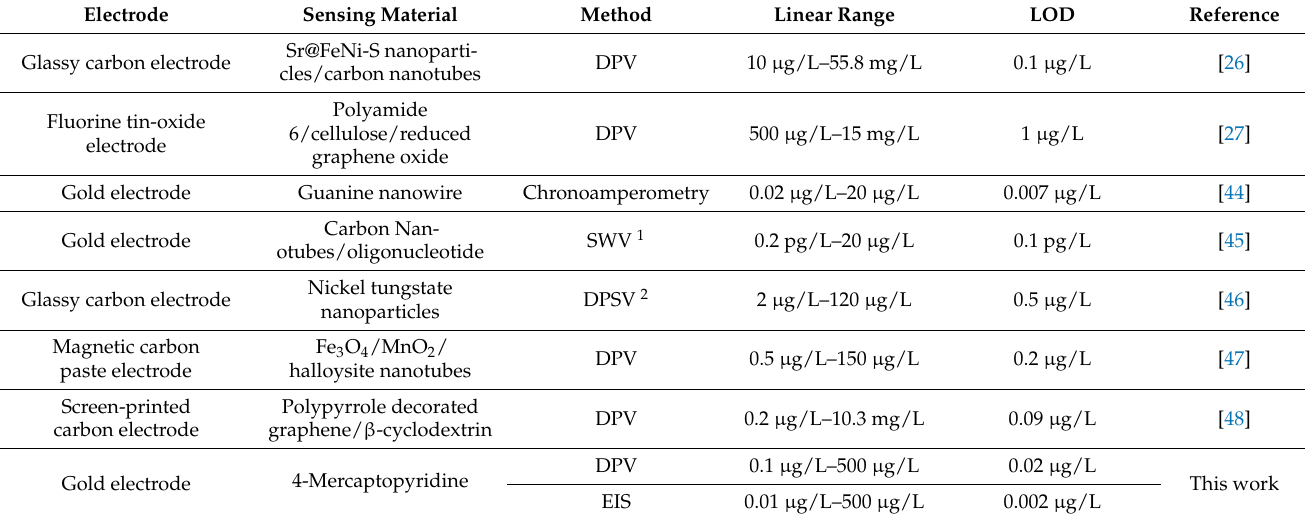
Table 1. Comparison with different assays via the electrochemical method for Hg 2+